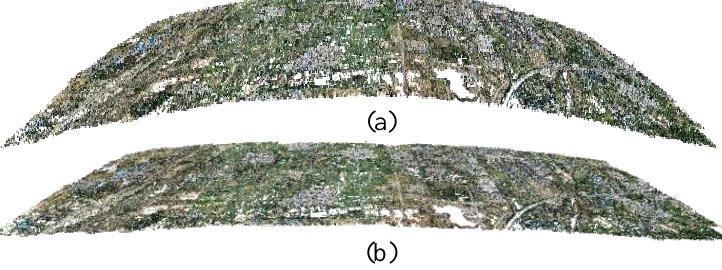
Figure 10. ( a ) The side view of the global SfM [12] reconstruction results on the towns dataset; ( b ) the side view of our method reconstruction results on the towns